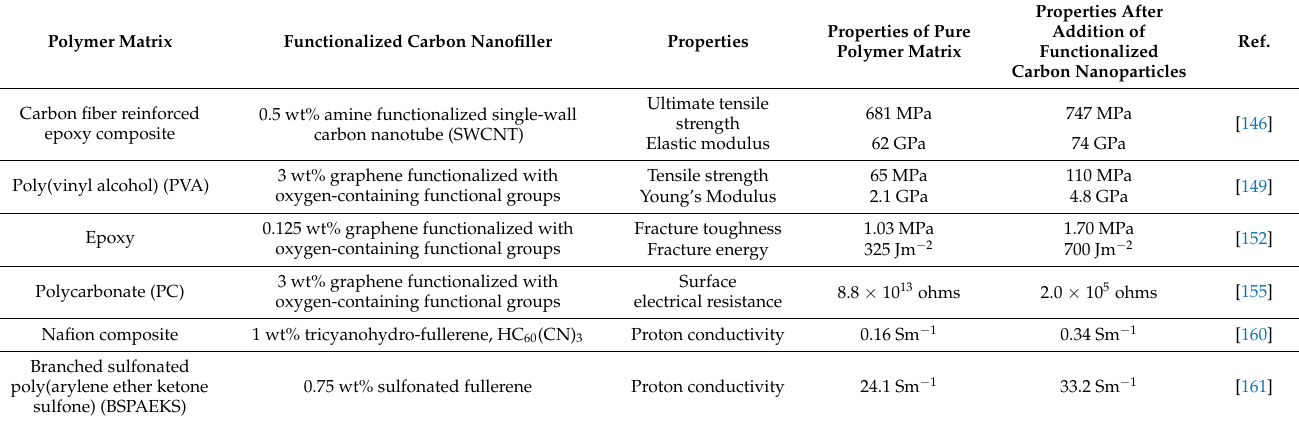
Table 10. Properties of polymer nanocomposite before and after addition of functionalized carbon nanoparticles. Polymer Matrix Functionalized Carbon Nanofiller Properties Properties of Pure Polymer Matrix